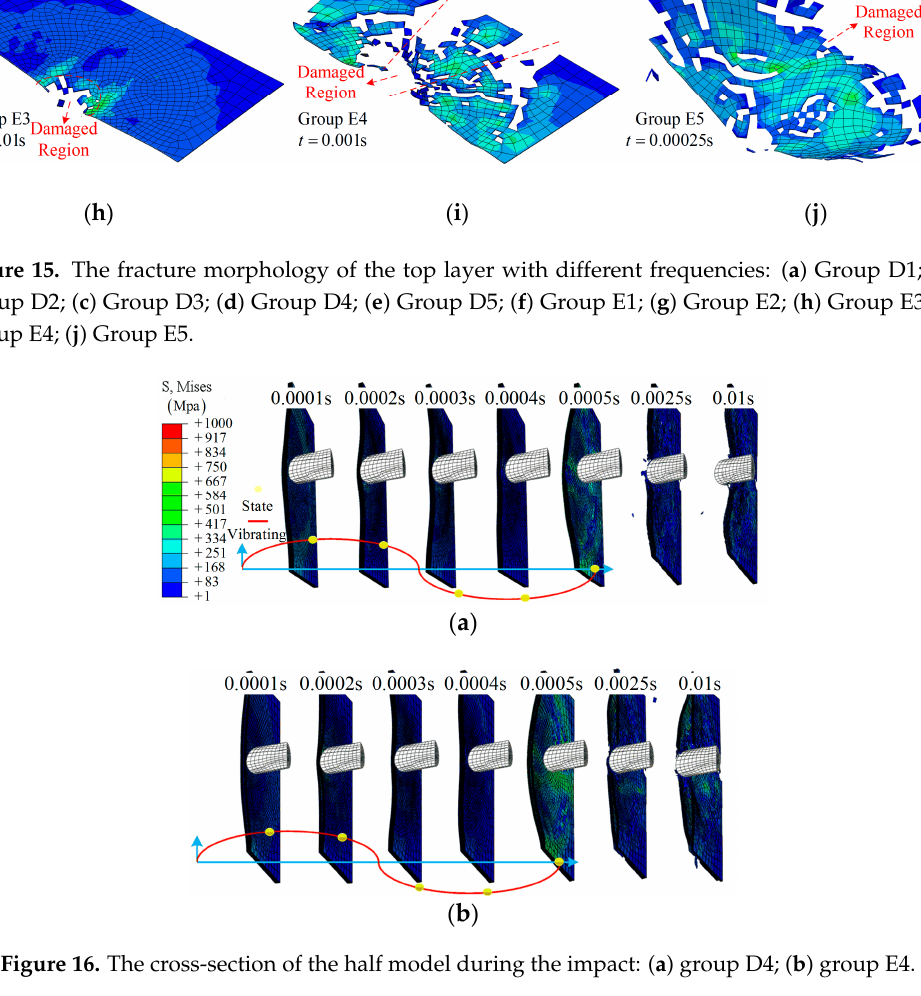
Figure 15. The fracture morphology of the top layer with different frequencies: ( a ) Group D1; ( b ) Group D2; ( c ) Group D3; ( d ) Group D4; ( e ) Group D5; ( f ) Group E1; ( g ) Group E2; ( h ) Group E3; ( i ) Group E4; ( j ) Group E5.